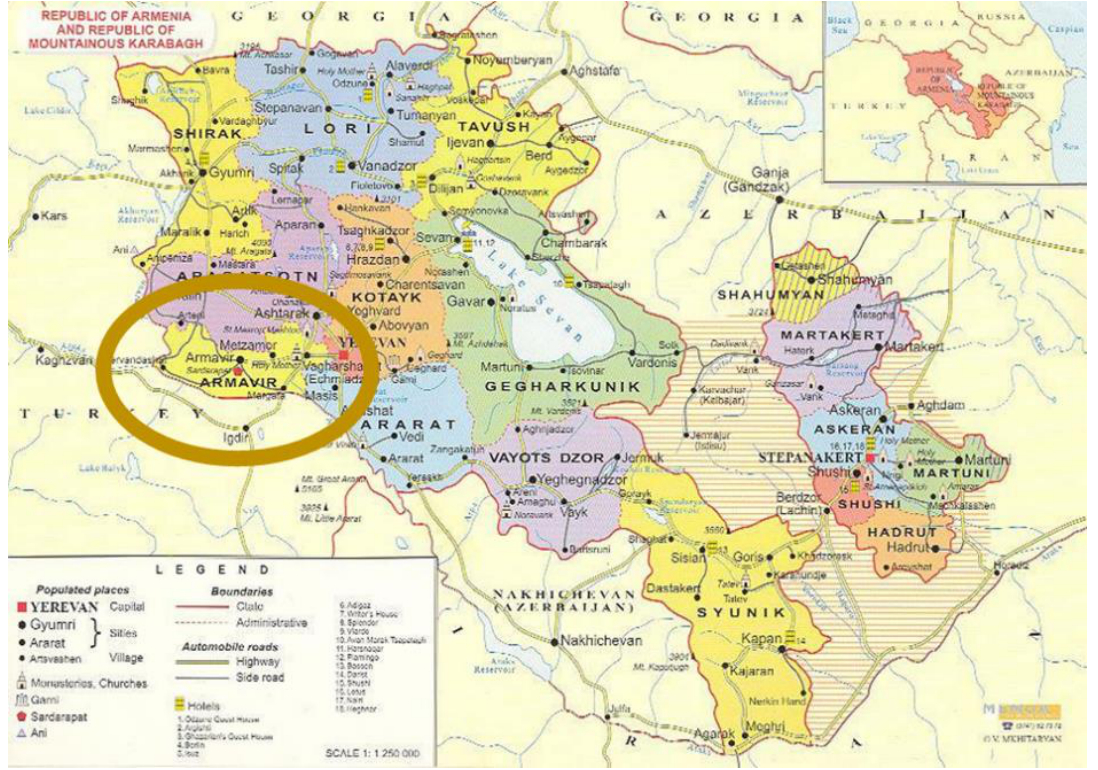
Figure 8. Map of Armenia, Armavir province.